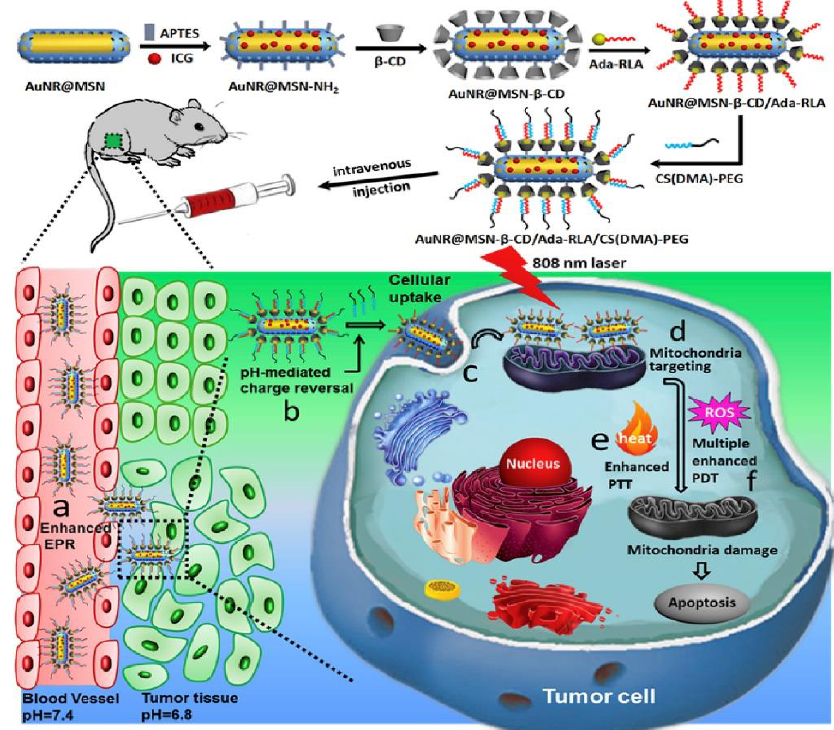
Figure 3. Schematic representation of multifunctional nanoplatform AuNR@MSN and its in vivo process. Reprinted with permission from reference [51] Copyright 2018 Elsevier.